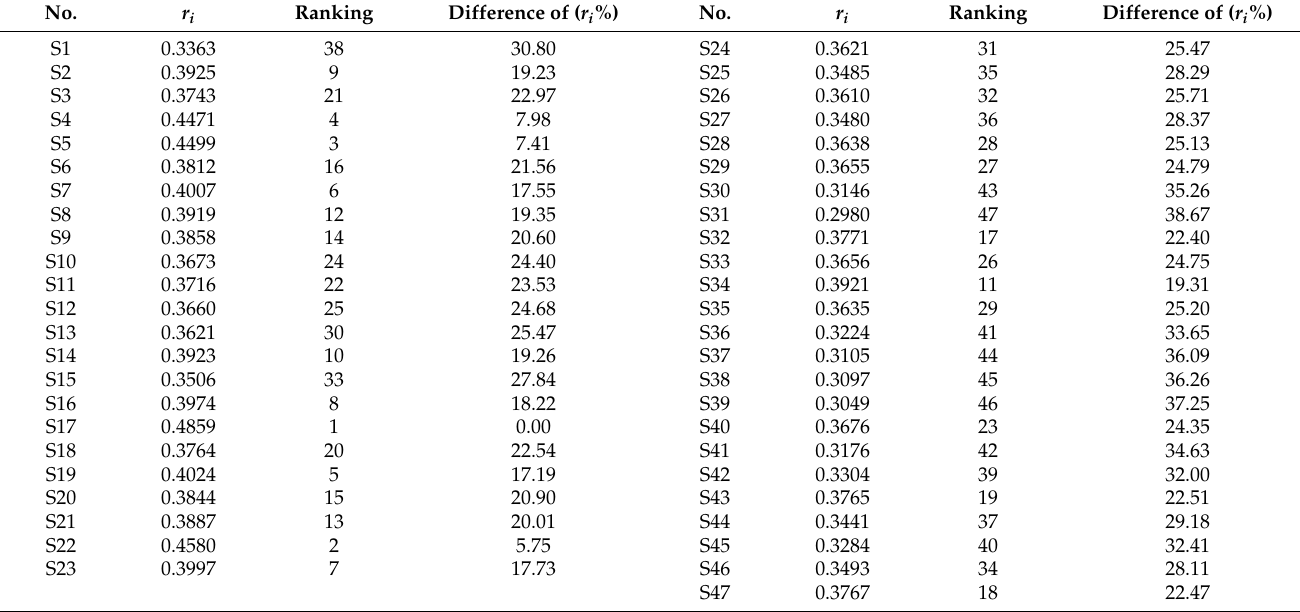
Table 3. Quality sequencing of the 47 tested